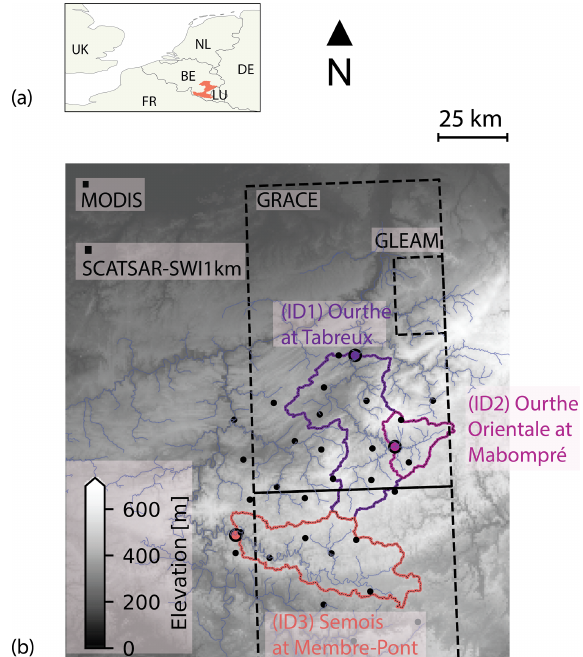
Figure 1. (a) Location of the study catchments in Belgium, north- western Europe. (b) Digital elevation model and catchments of the Ourthe upstream of Tabreux (ID1), Ourthe Orientale upstream of Mabompré (ID2) and Semois upstream of Membre-Pont (ID3). Pixel size of GRACE, GLEAM, MODIS and SCATSAR-SWI1km. Colored dots are the streamflow gauging locations, and black dots are the precipitation